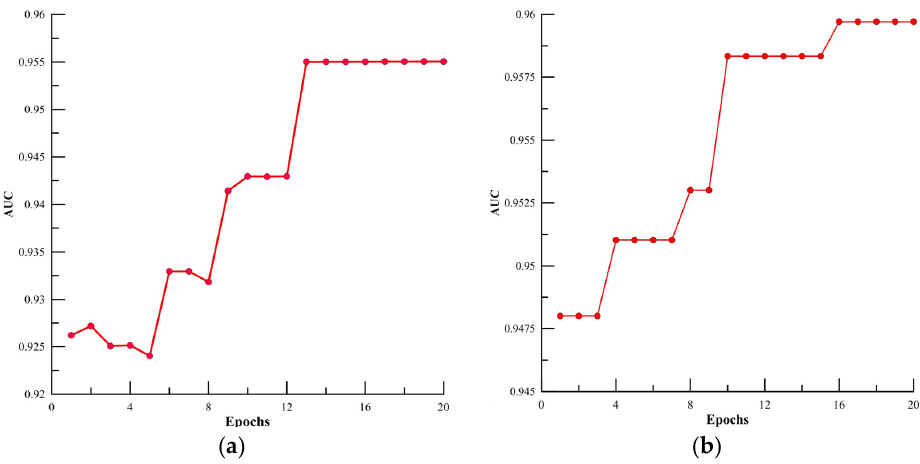
Figure 11. Curves of AUC value: ( a ) BA-AdaBoost; ( b ) FA-AdaBoost.